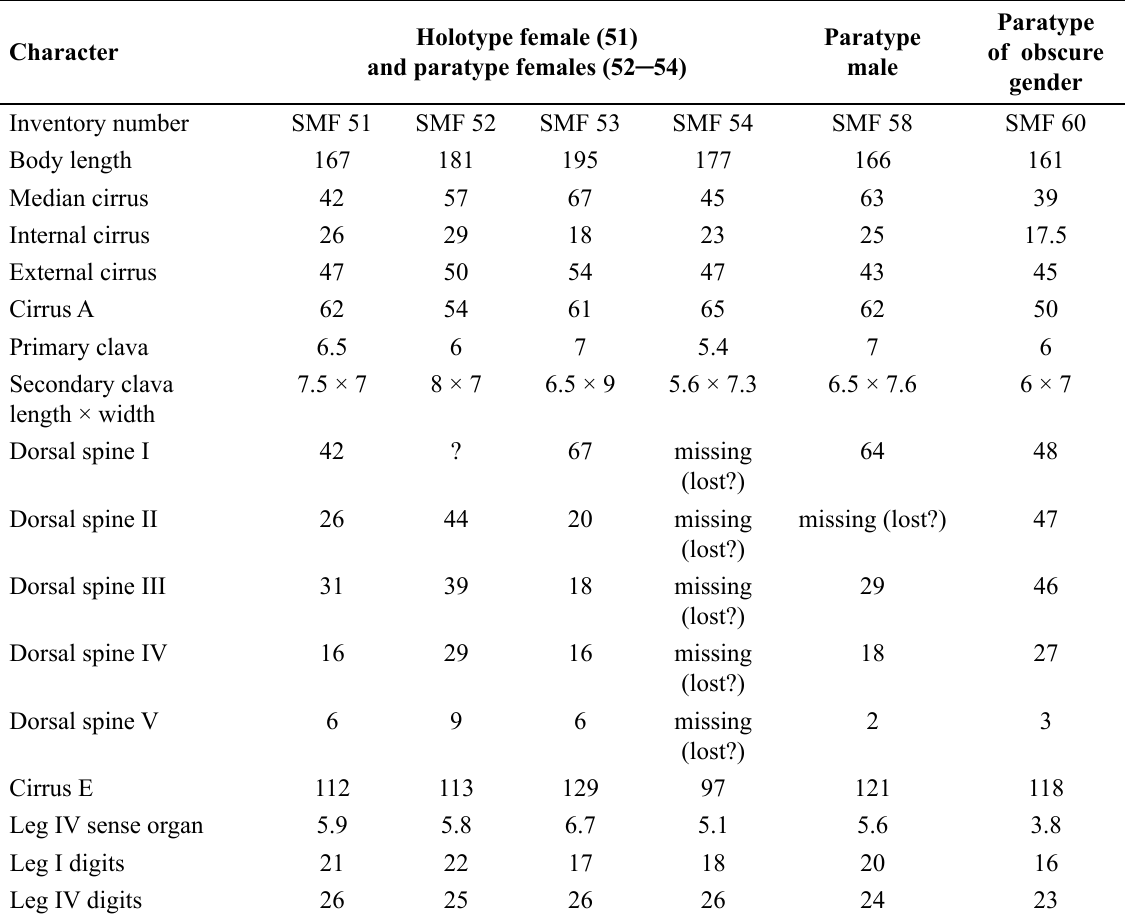
Table 1. Measurements (in μm) of Neostygarctus grossmeteori sp.